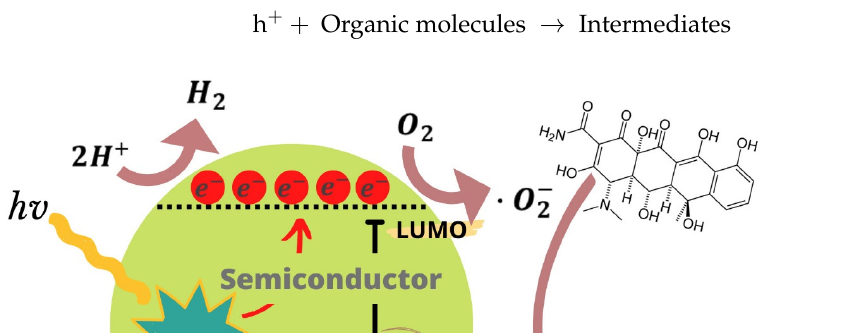
Table 1. Recommended tests for photocatalytic materials according to the International Organization for Standardization.